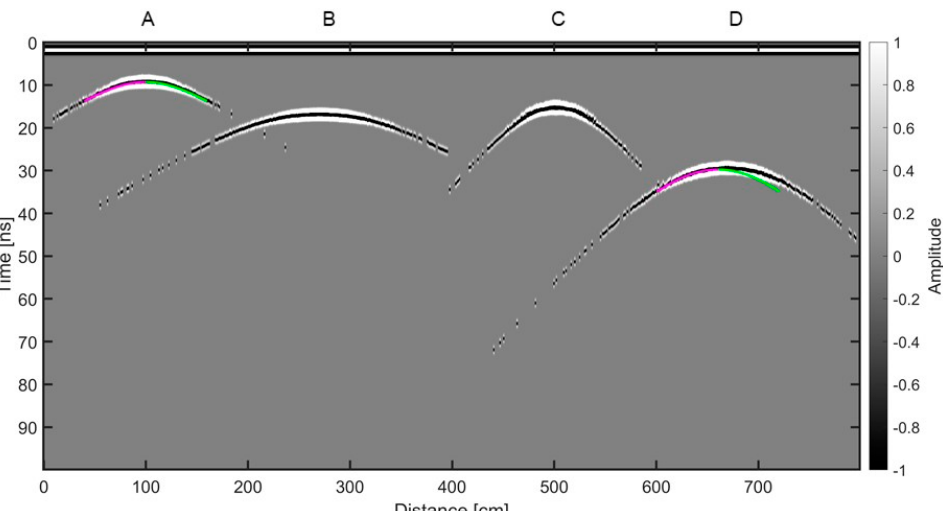
Figure 3. The synthetic GPR section showing the events generated by the buried objects of the model in Figure 2. Two fitting hyperbolas with their left (magenta) and right (green) arms are also displayed. While in A the whole hyperbola matches quite well the observed diffraction, in D only the magenta arm shows a good fit. This is because only the left arm of the diffracted event is used in the velocity analysis. Including also the right arm would result in an incorrect velocity estimation due to the fact that the object in D, for its dimension, is not a point diffractor, and consequently the shape of the observed event is not a true hyperbola. Table 1. Parameters used in the velocity analysis on synthetic data by the coherency functionals.